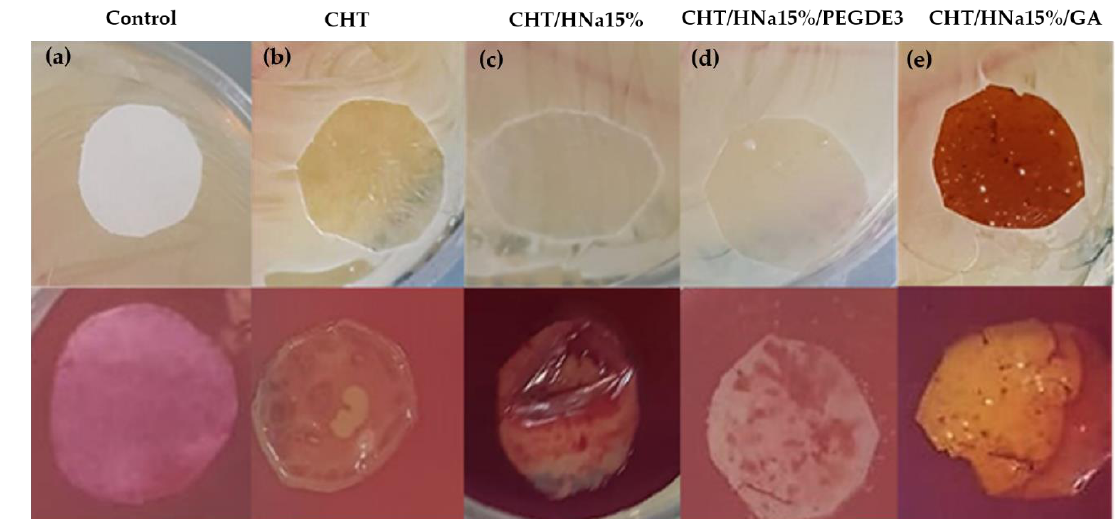
Figure 10. Antimicrobial activity against S. tiphimurium of chitosan discs; ( a ) Control, ( b ) CHT, ( c ) CHT/HNa15, ( d ) CHT/HNa15%/PEDGE3, ( e ) CHT/HNa15%/GA. Before 24 h (top) and after 24 h (bottom) of inoculation.